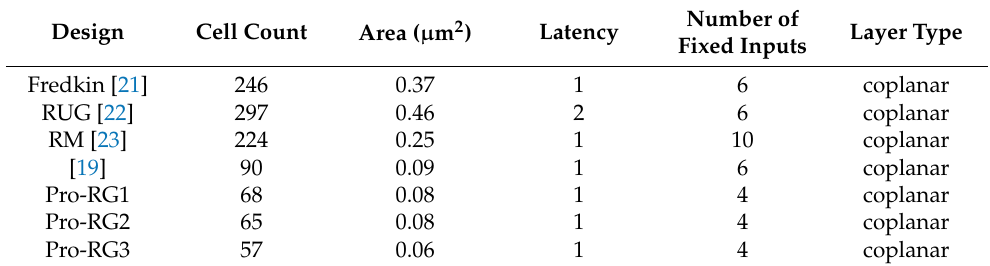
Figure 19. Logic functions implemented by the reversible gate in [19]. ( a ) 𝐹1 = 𝐴𝐵(cid:3364)𝐶 ; ( b ) 𝐹 = 𝐴̅𝐵𝐶 + 𝐴̅𝐵(cid:3364)𝐶̅ . Table 7. Comparisons of the performance for alternative reversible gates.